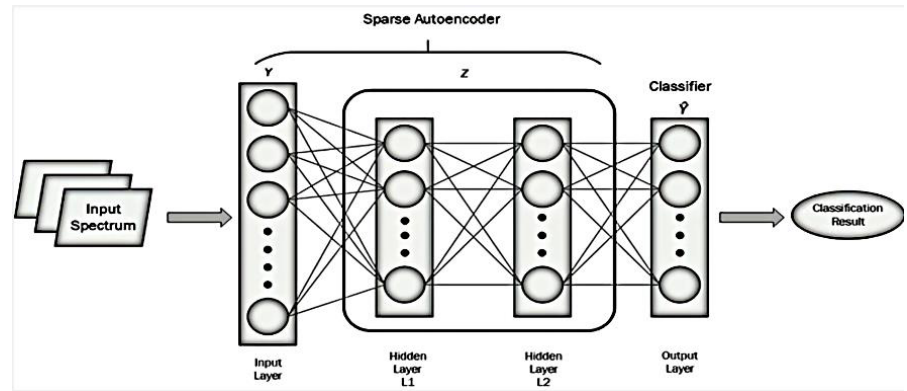
Figure 7. Architecture of deep-sparse auto-encoder (SAE).